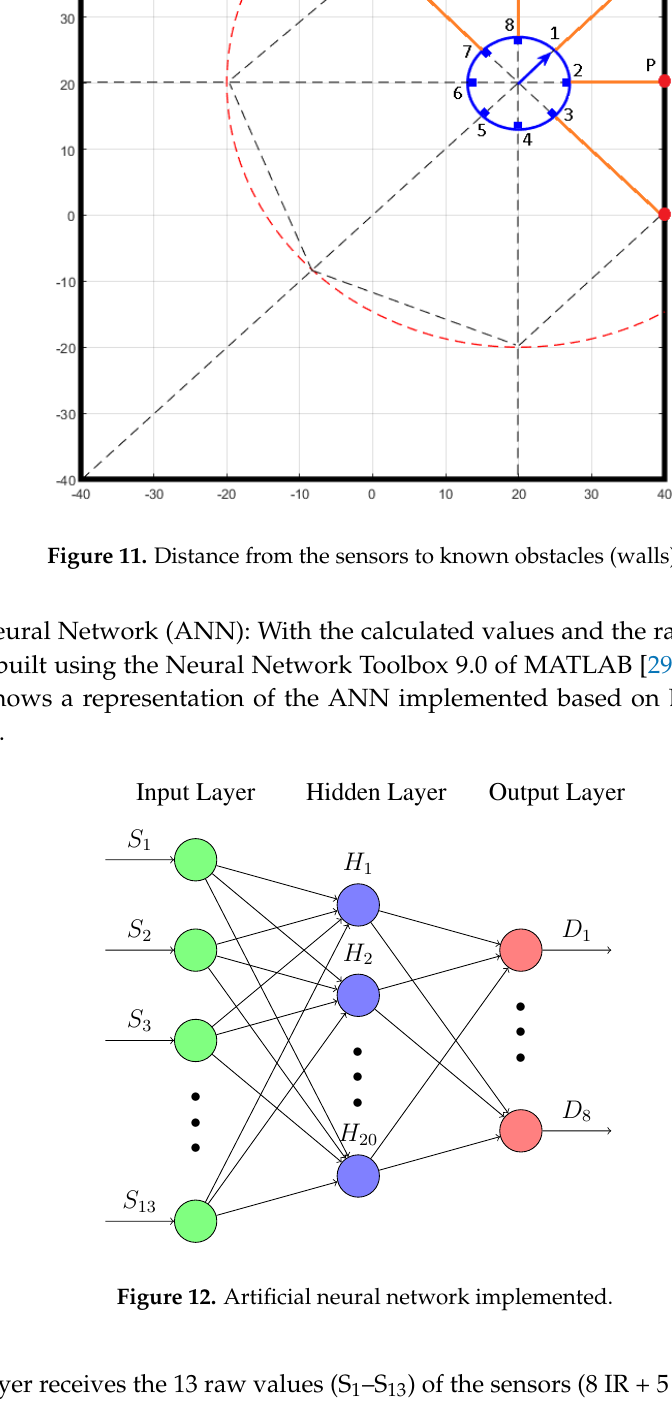
Figure 11. Distance from the sensors to known obstacles (walls)